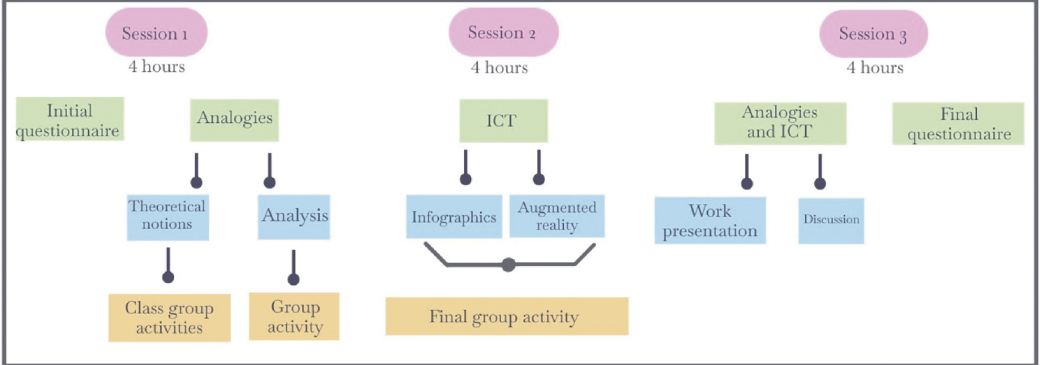
Figure 2. Development of training